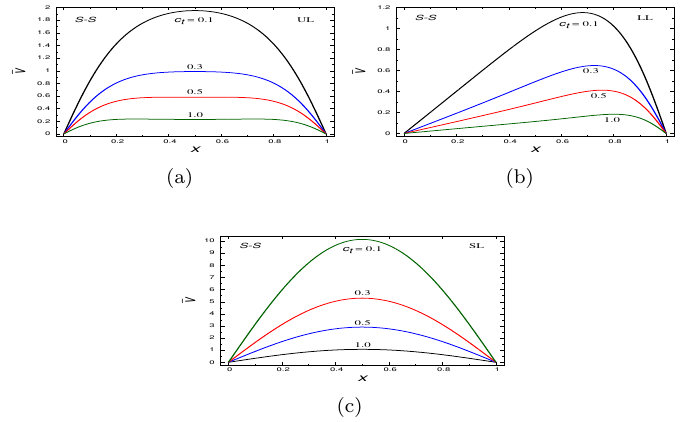
Figure 6. Effect of viscous damping parameter c t on the distribution of angular displacement along the axial direction of a S-S CNT subjected to: (a) UL, (b) LL, and (c) SL.